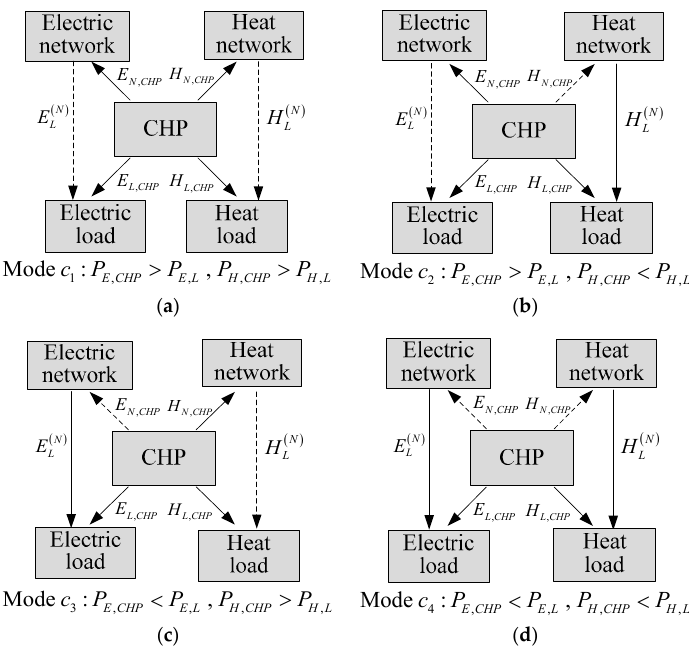
Figure 4. Operation modes of CHP in: ( a ) C 1 mode; ( b ) C 2 mode; ( c ) C 3 mode; and ( d ) C 4 mode.